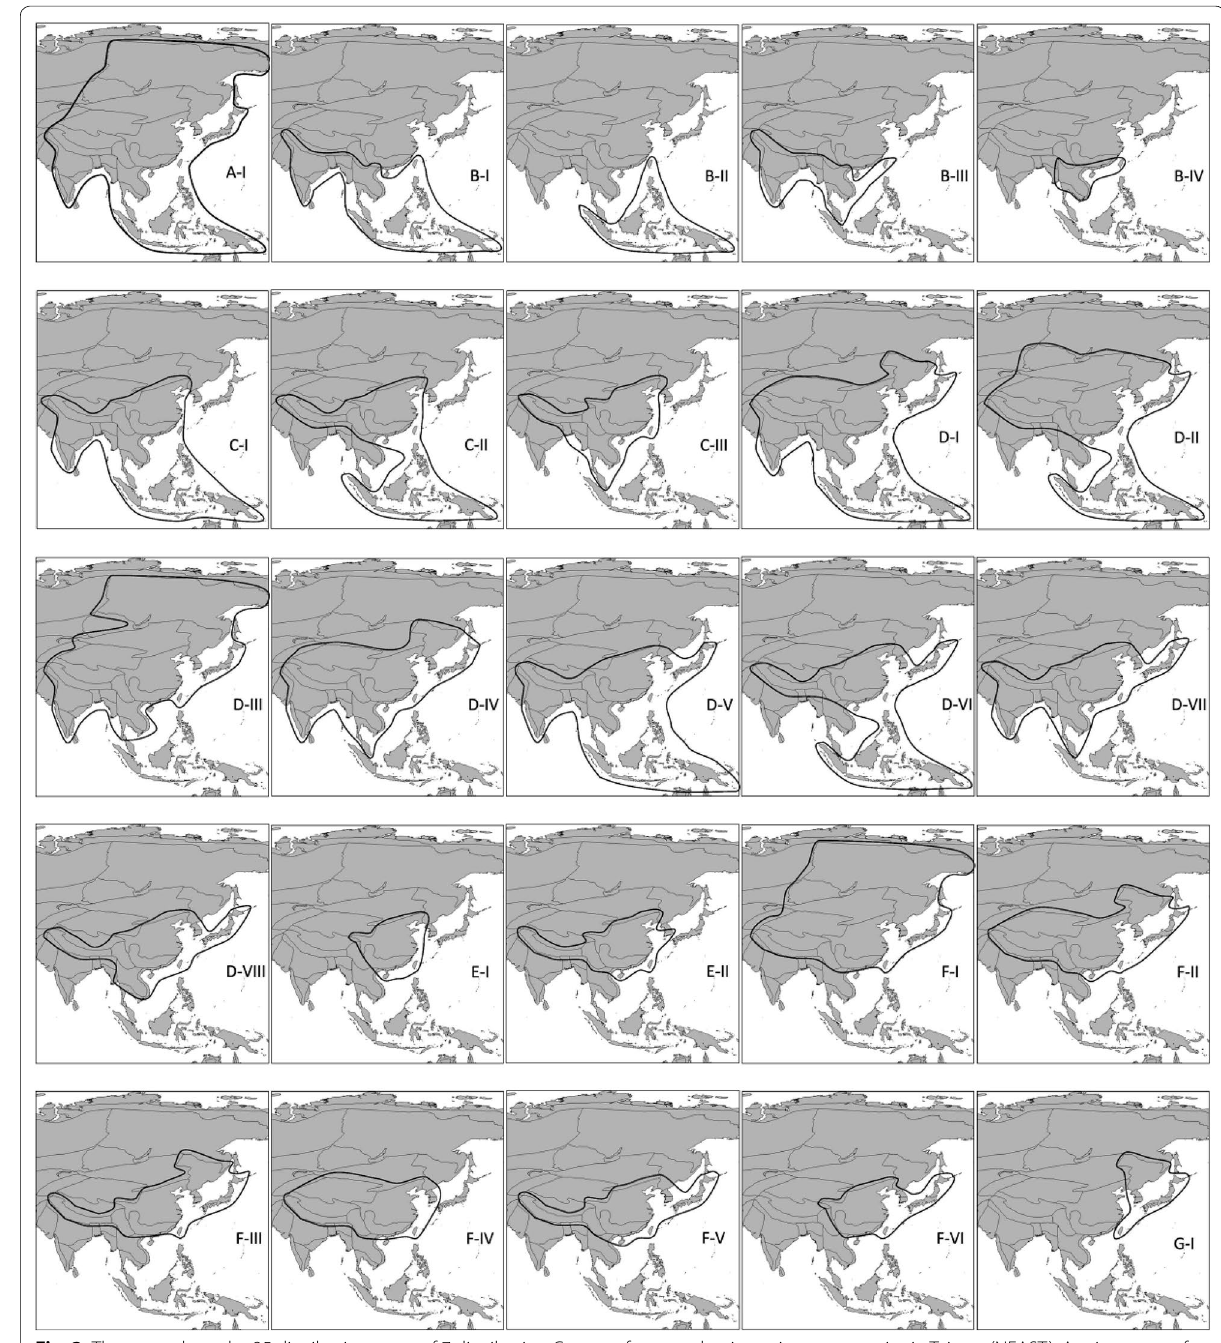
Fig. 3 The maps show the 25 distribution types of 7 distribution Groups of non‑endemic angiosperm species in Taiwan (NEAST). Angiosperms of Group A distribute from tropical islands to subarctic Siberia. B‑I to B‑IV are tropical distribution. C‑I to C‑III are tropical to subtropical distribution. D‑I to D‑VIII are tropical to temperate distribution. E‑I to E‑II are subtropical distribution. F‑I to F‑VI are subtropical to temperate distribution. G is temperate distribution. There are 2428 NEASTs evaluated in this research. The detail descriptions of distribution ranges and the numbers of